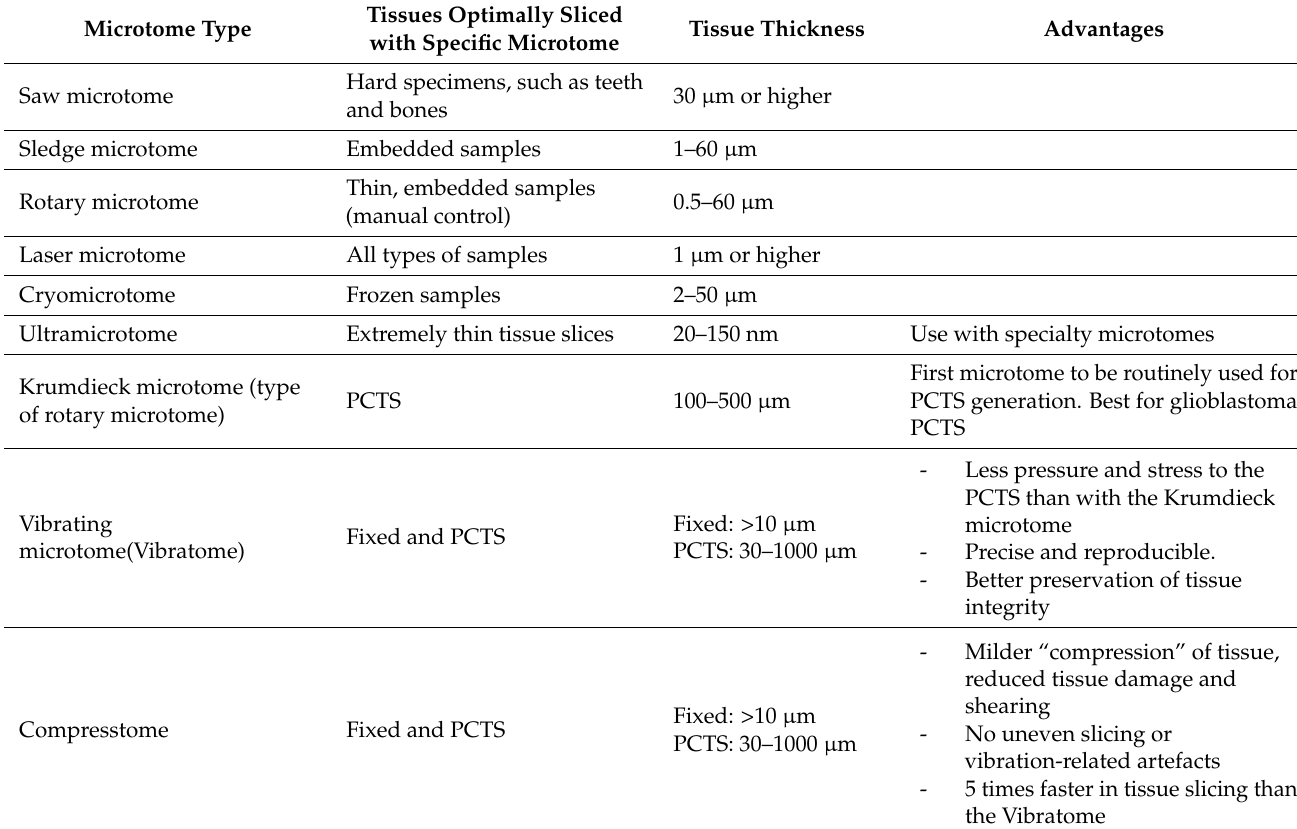
Table 1. Summary of different microtomes available for tissue